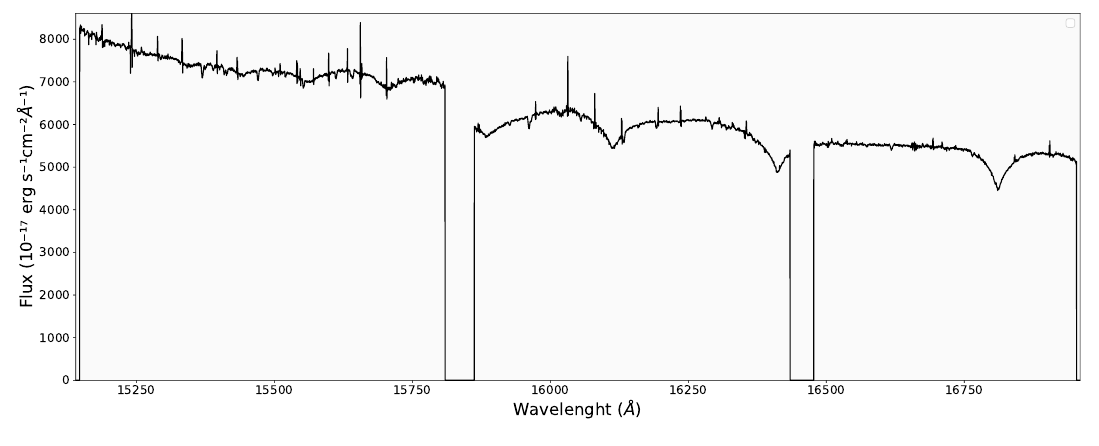
Figure 1. APOGEE